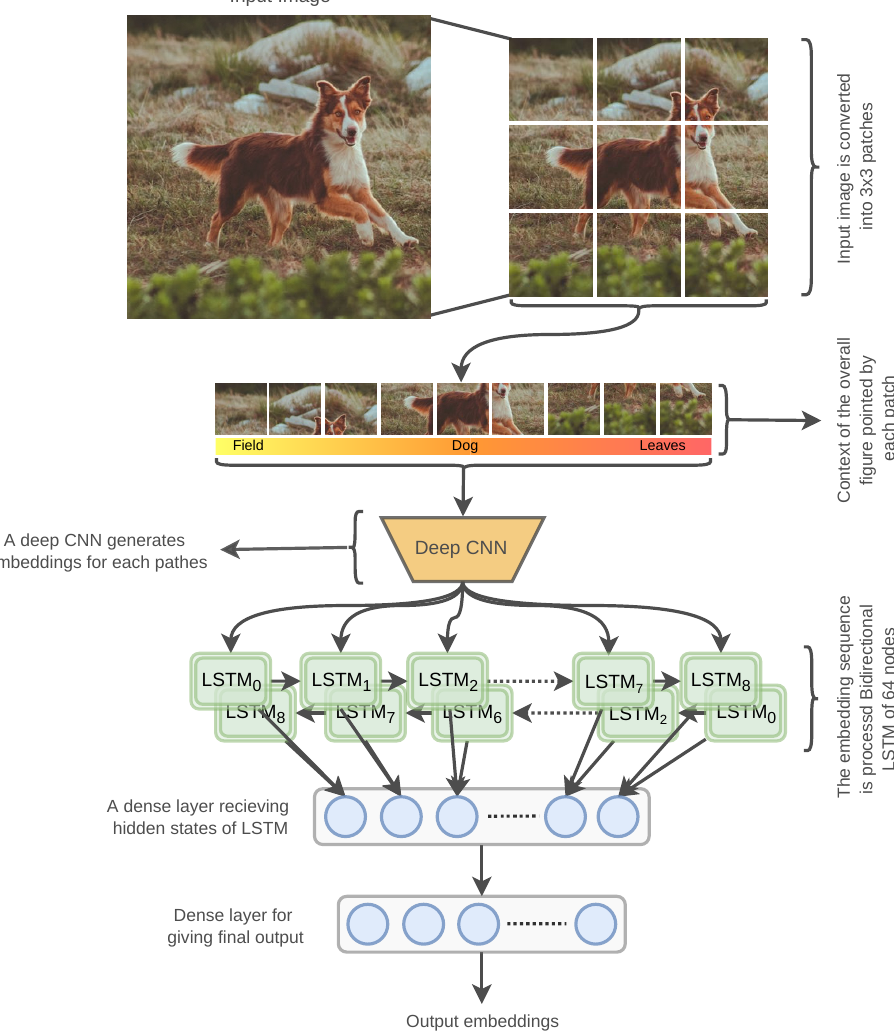
Figure 3. The figure illustrates the recurrent patching for generating local descriptors using DCNN architecture. A given image is firstly patched, and each patch is fed to the DCNN to generate embeddings for each patch. The embeddings are condensed using a bi-directional LSTM layer of 64 nodes. The condensed features are passed into dense layers for generating final